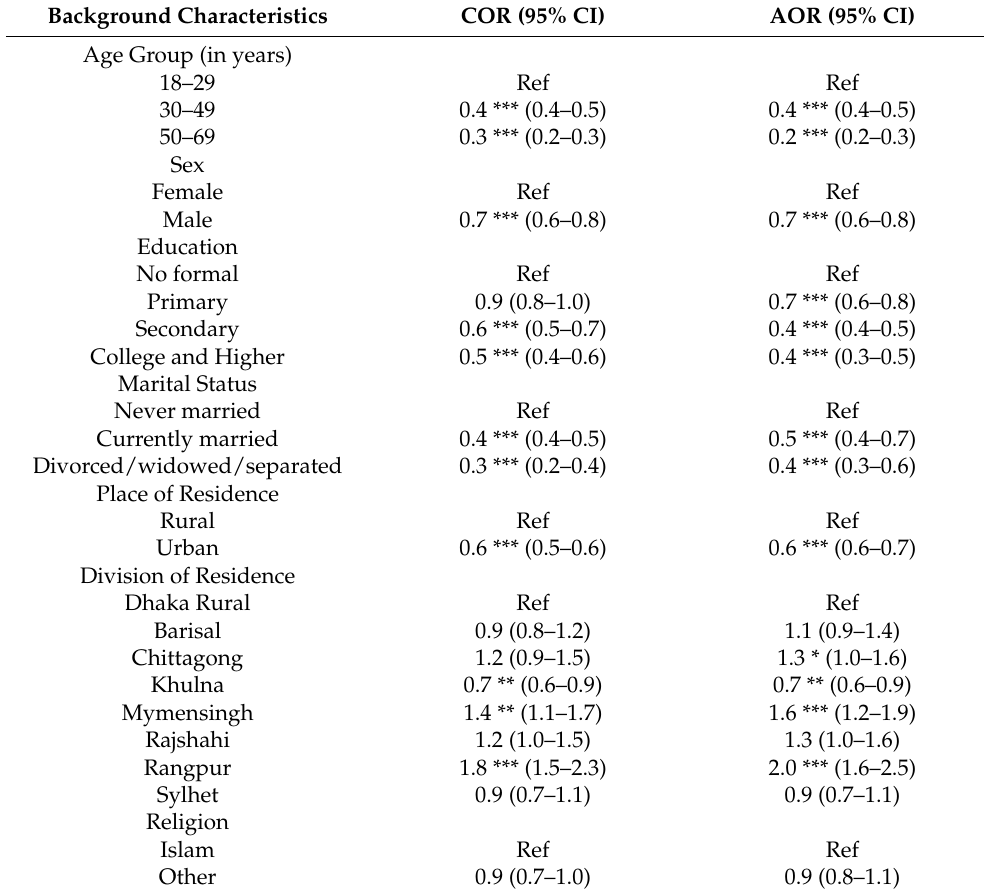
Table 2. Logistic regression showing the factors associated with the ideal cardiovascular metric in the adult Bangladeshi